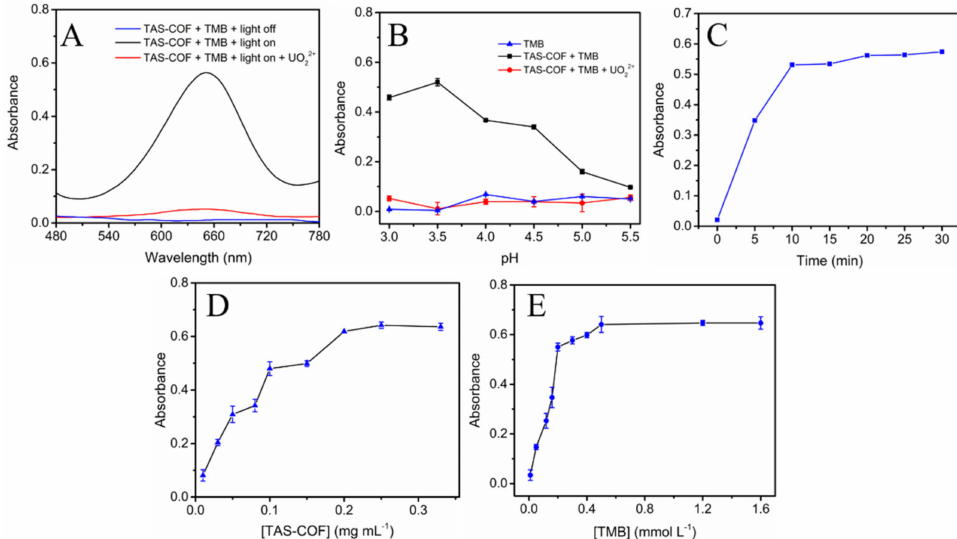
Figure 3. UV-vis spectra of TAS-COF + TMB system with/without the presence of UO 22+ ( A ). The effect of pH on the absorbance at 650 nm of TMB, TAS-COF + TMB, TAS-COF + TMB + UO 22+ under visible light irradiation ( B ). The effect of irradiation time ( C ), TAS-COF concentration ( D ), and TMB concentration ( E ) on the absorbance at 650 nm of the sensing